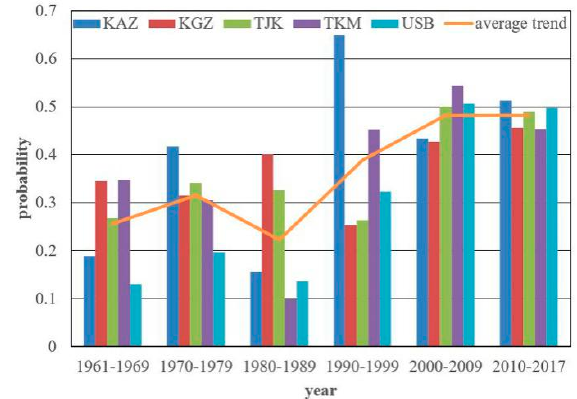
Figure 9. The 3D drought risk (joint probability) of five countries in CA.